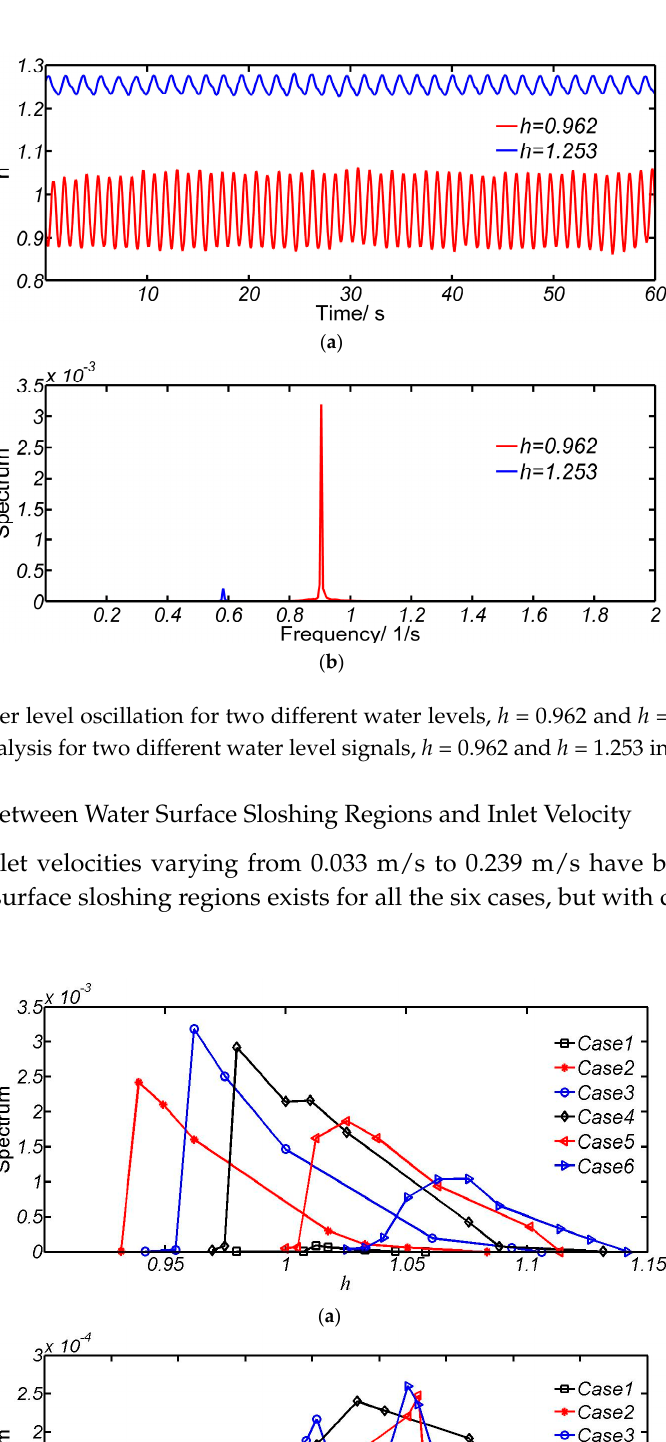
Table 2. Power spectral density with water level (exp.) for case 3. Region 1